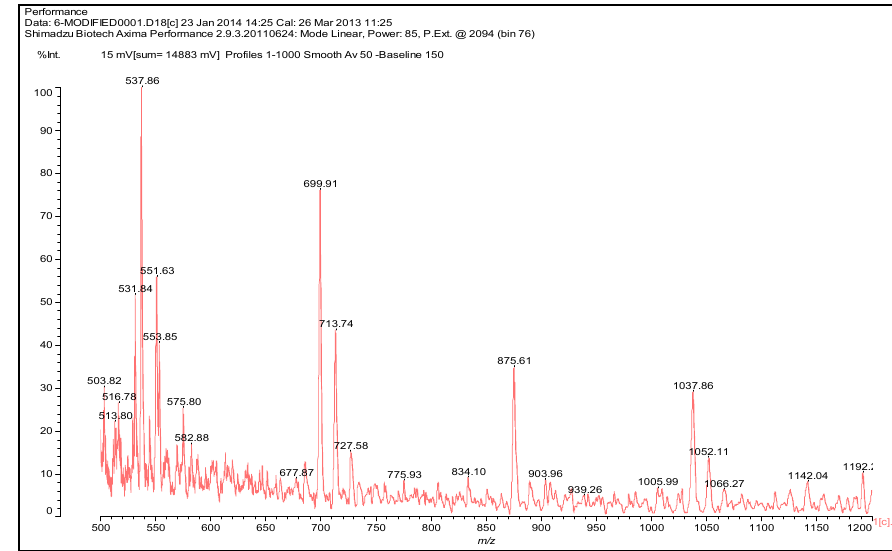
Figure 6. MALDI TOF spectrum of the UG resin.